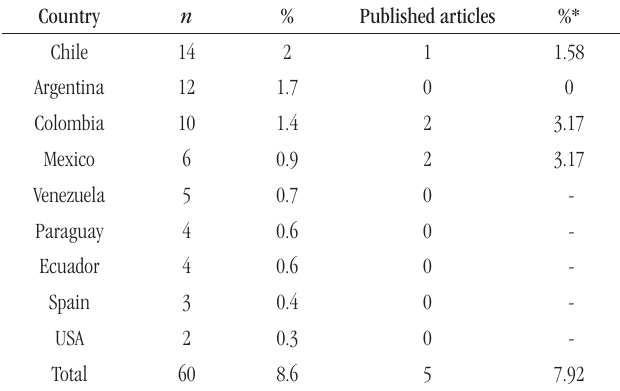
taBLE 2 − Relationship between absolute and relative values of the papers presented as abstracts and articles published, according to foreign countries Country n % Published articles